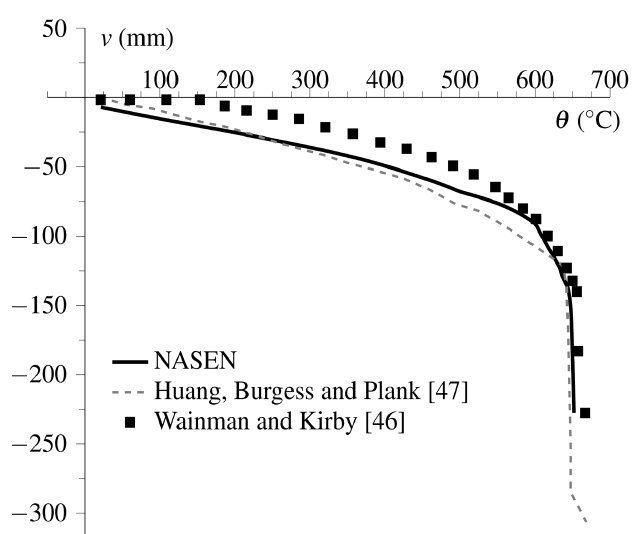
Figure 14. Vertical displacement in the middle-span of the composite beam as a function of